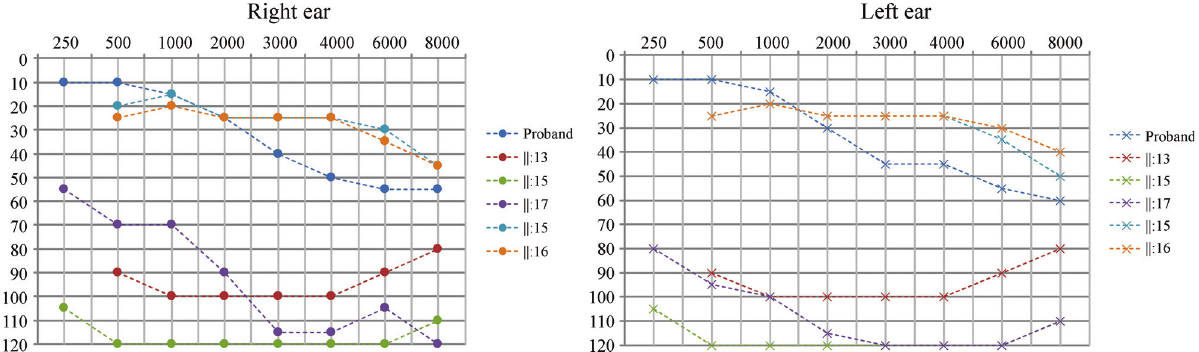
Figure 2 - Tonal audiometry showing thresholds for six affected